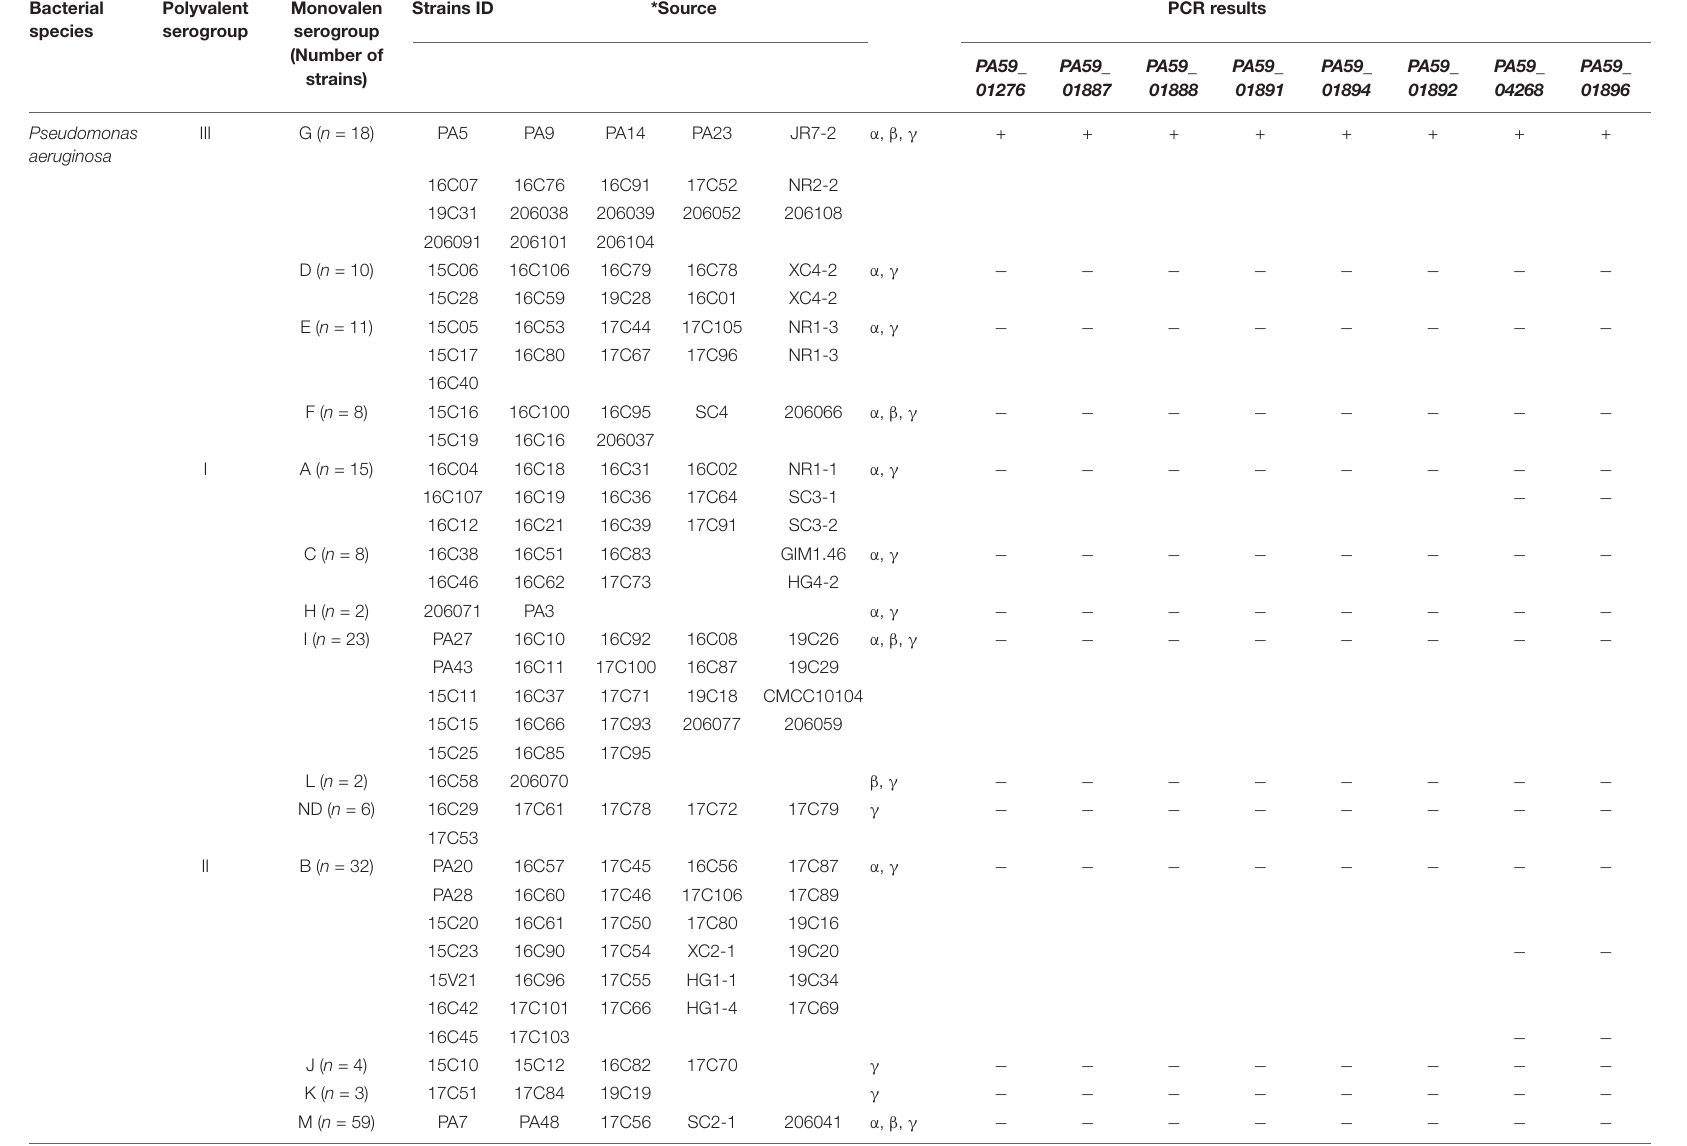
TABLE 1 | Bacterial strains used in this study and PCR specificity results. Bacterial